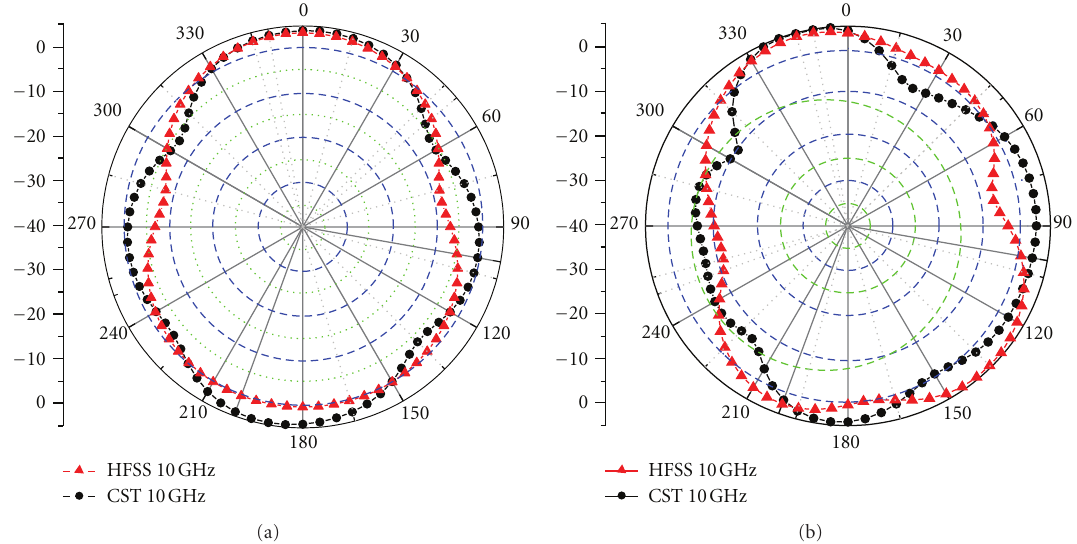
Figure 10: Radiation patterns of the proposed antenna at 10 GHz; (a) xoz-plane, (b) yoz-plane.